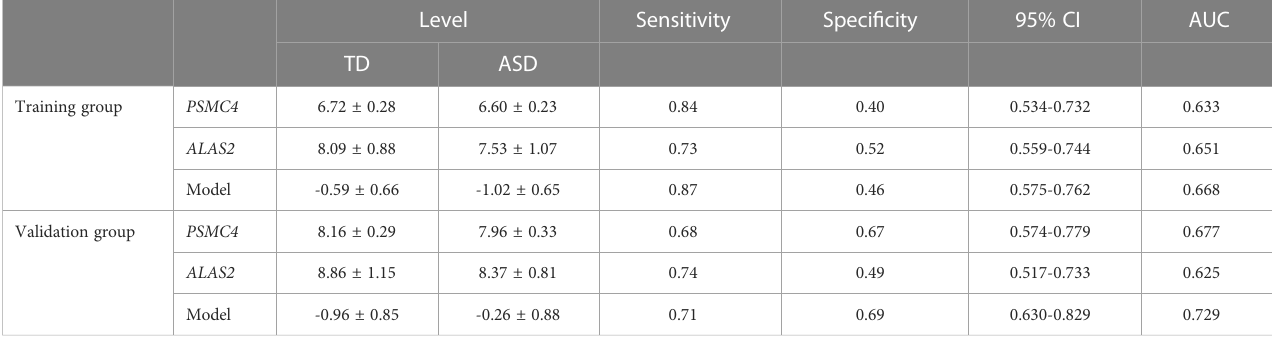
TABLE 3 Receiver operative characteristic curves of PSMC4 , ALAS2 , and Model ( PSMC4 + ALAS2 ) in the training and validation